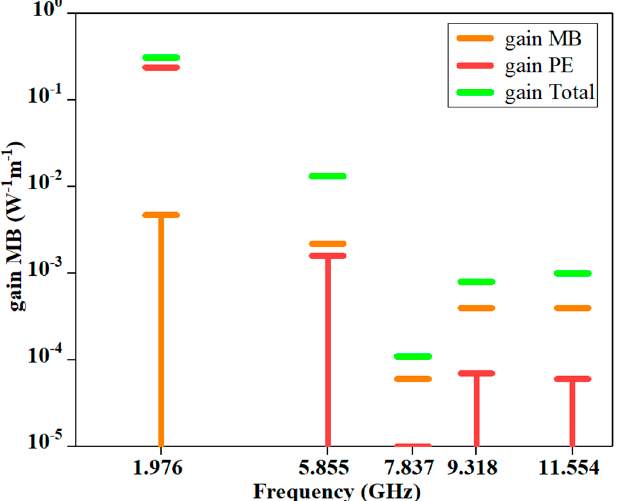
Figure 3. Contribution of different effects to the FSBS gain coefficient in the stimulated Brillouin scattering process, including the MB effect (orange short line), radiation pressure effect (red short line) and the entire Brillouin contribution of gain (short green line, when the waveguide width w = 1500 nm.